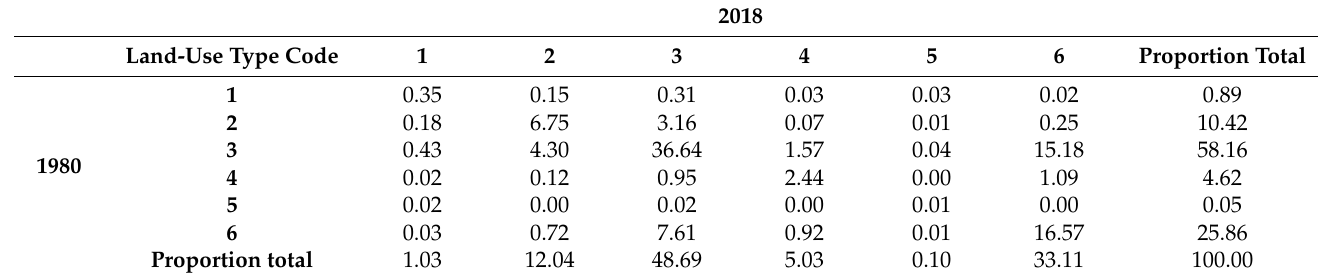
Table 4. The proportion of land-use type spatial transfer area on the QTP from 1980 to 2018 (%).